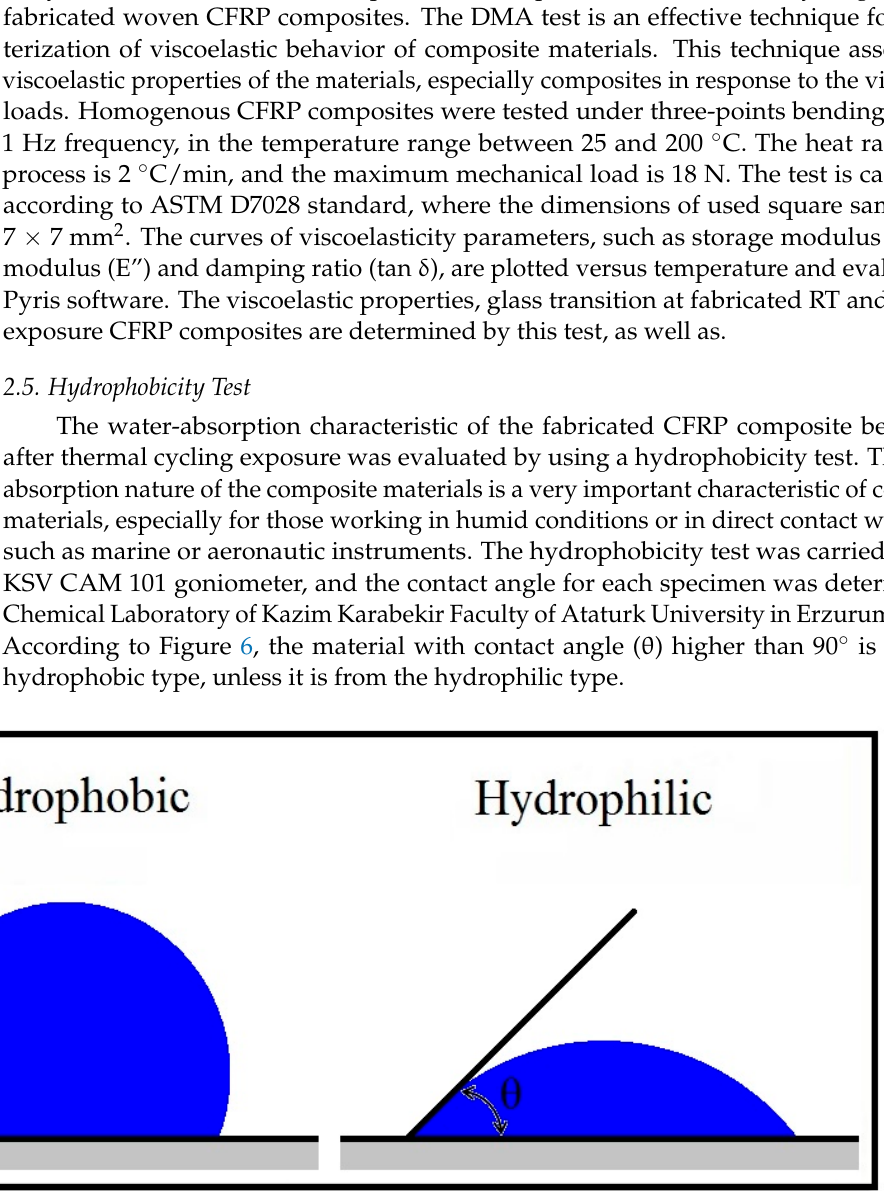
Figure 6. Contact angle in hydrophobicity test.